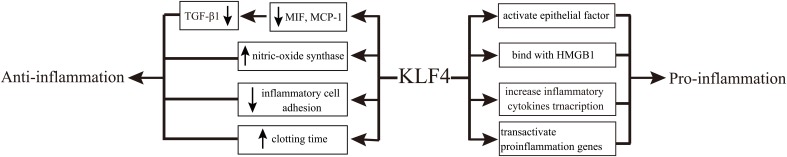
The role of KLF4 in kidney inflammation.